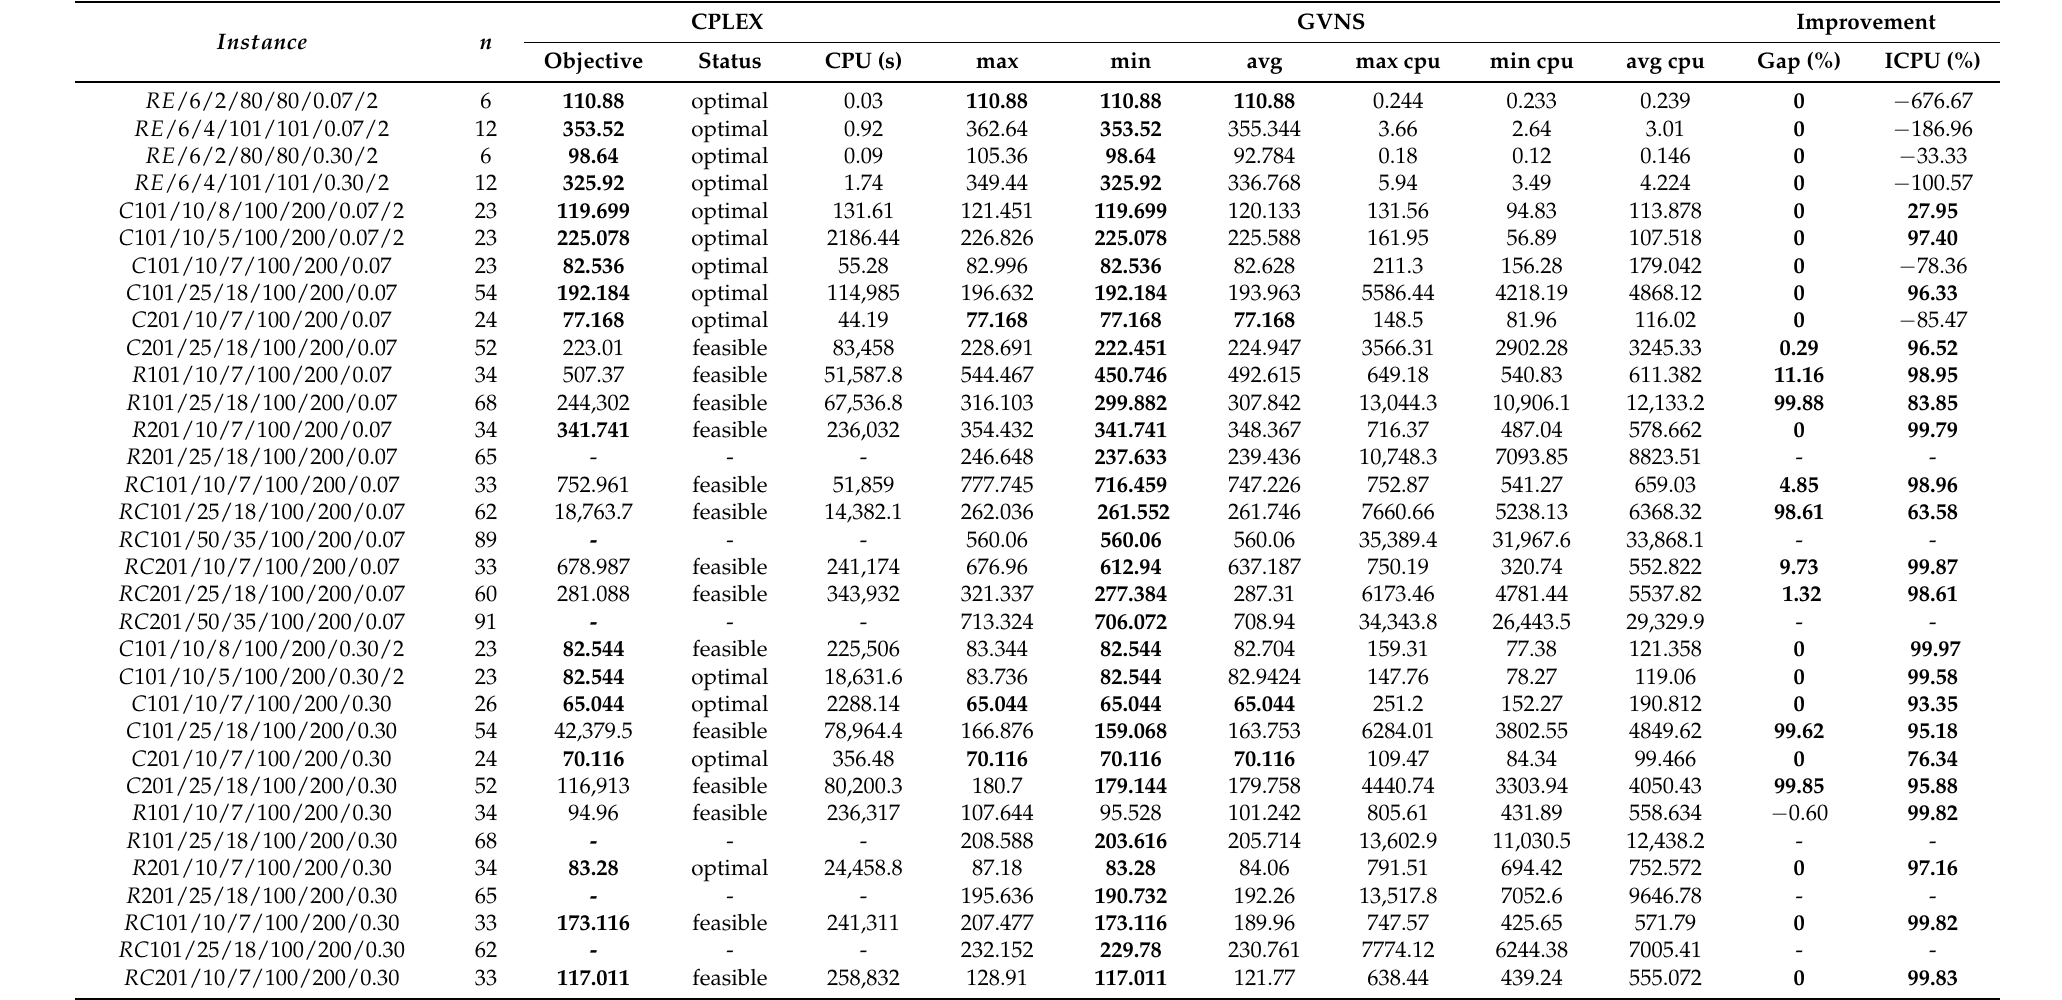
Table 1. Results of mono-objective GVNS for the routing